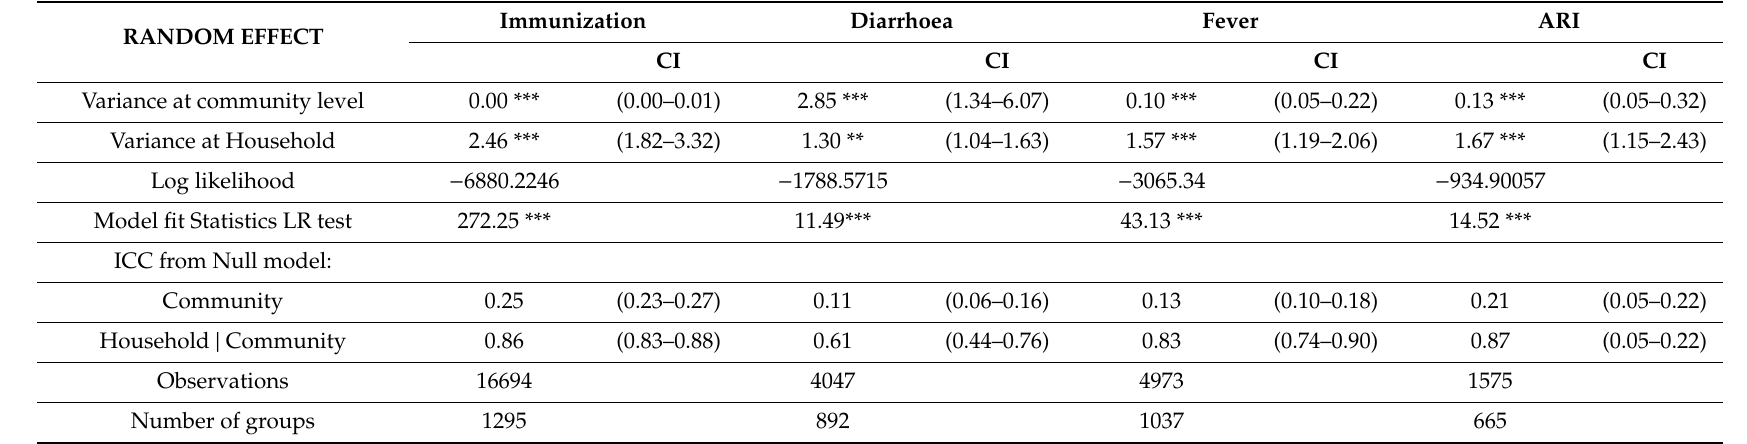
Table 3. Random E ff ects from the Multilevel Logistic Regression on Preventive and Curative Child Healthcare in Nigeria.